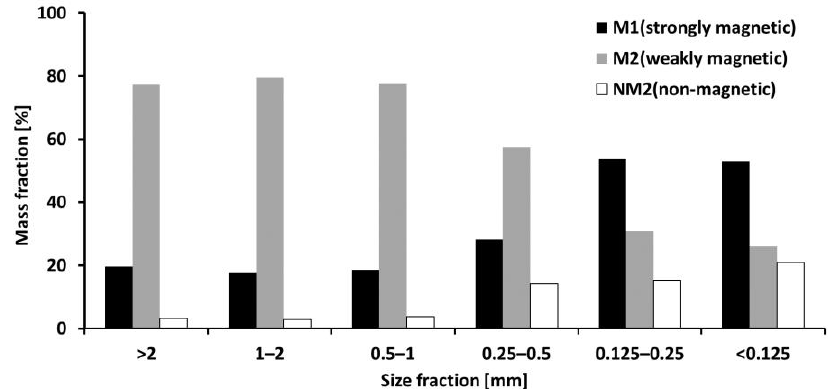
Figure 7. Mass balance after separation for all size fractions of HC FeCr slag.